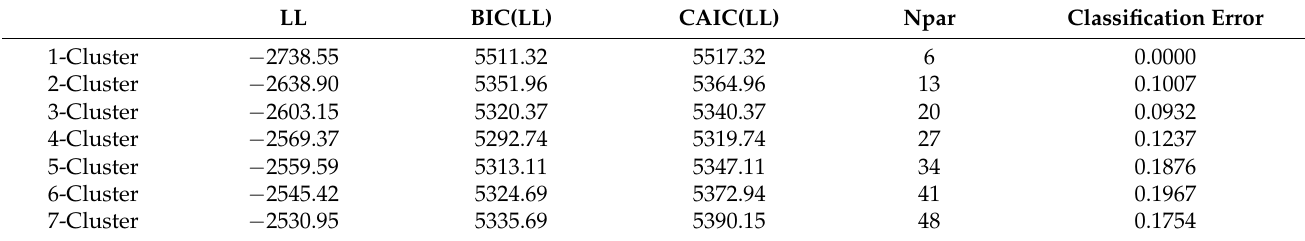
Table 2. Summary of latent profile cluster models.